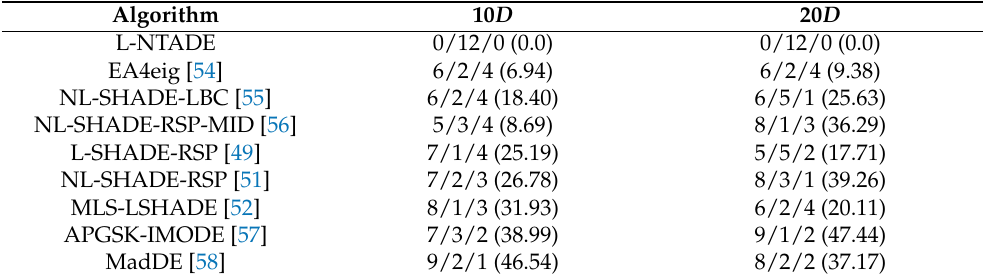
Table 4. Mann–Whitney tests of L-NTADE against the competition top 3, CEC 2022, and other approaches, number of wins/ties/losses and total standard score.